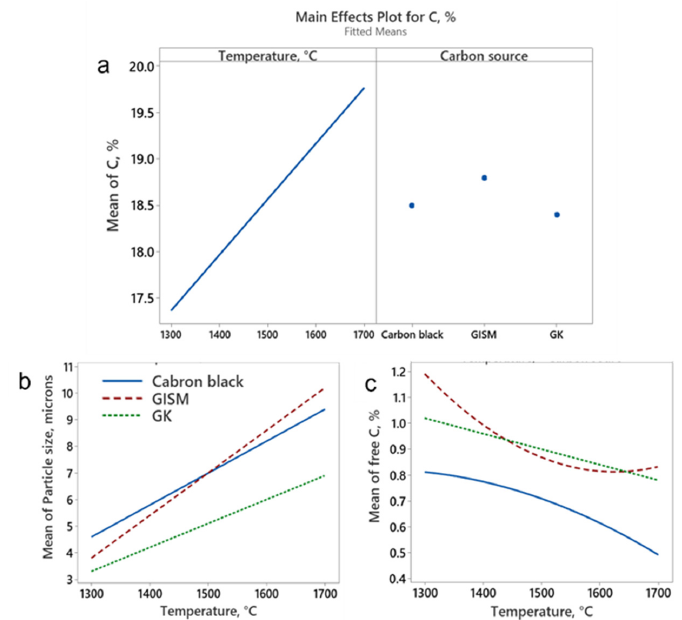
Figure 1. Main effect plots for the influence of temperature and carbon precursor on the total carbon content ( a ), free carbon content ( b ), and average TiC particle size ( c ).